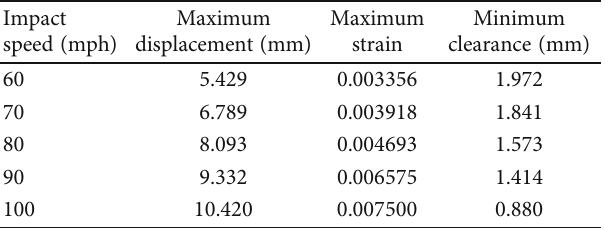
Figure 28: Maximum displacement, minimum gap, and maximum strain of the battery box at di ff erent impact speeds. Table 12: Battery box response at di ff erent bird